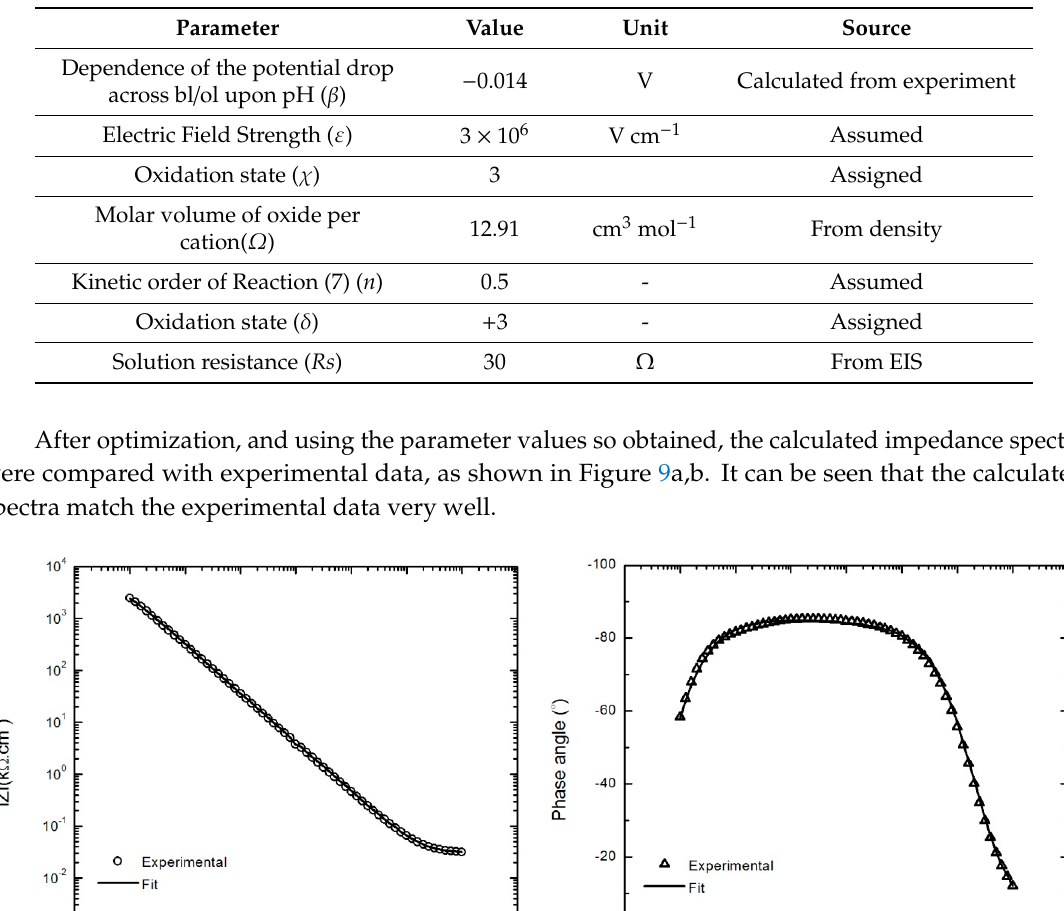
Table 2. Known, constant parameter used in optimization of EIS data with their sources.